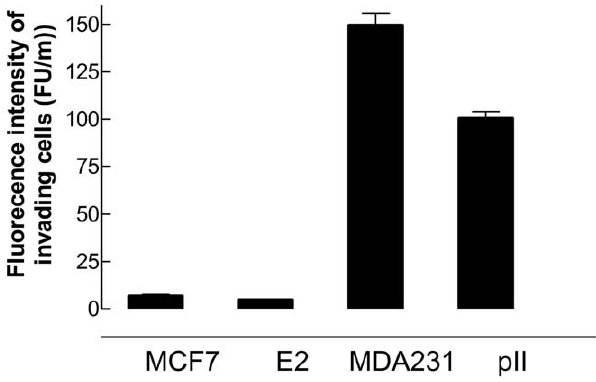
Figure 4. Invasion assay of MCF7, E2, pII and MDA231 cells through simulated ECM protein components. Cells were plated into the upper chambers of the cell invasion plate and incubated for 48 h prior to measurement of the fluorescence intensity of the invading cells in the bottom chambers. MCF7 and E2 cells were considered non- invasive ( , 20 FU/m), whereas pII and MDA231 cells progressively invaded the BME ( . 100 FU/m). Histobars represent the mean 6 SEM of at least 3 independent determinations of the fluorescent intensity of the invading cells in the bottom chamber. This experiment was performed three times with similar outcome. pII and MDA231 significantly different from MCF7 with p , 0.0001.